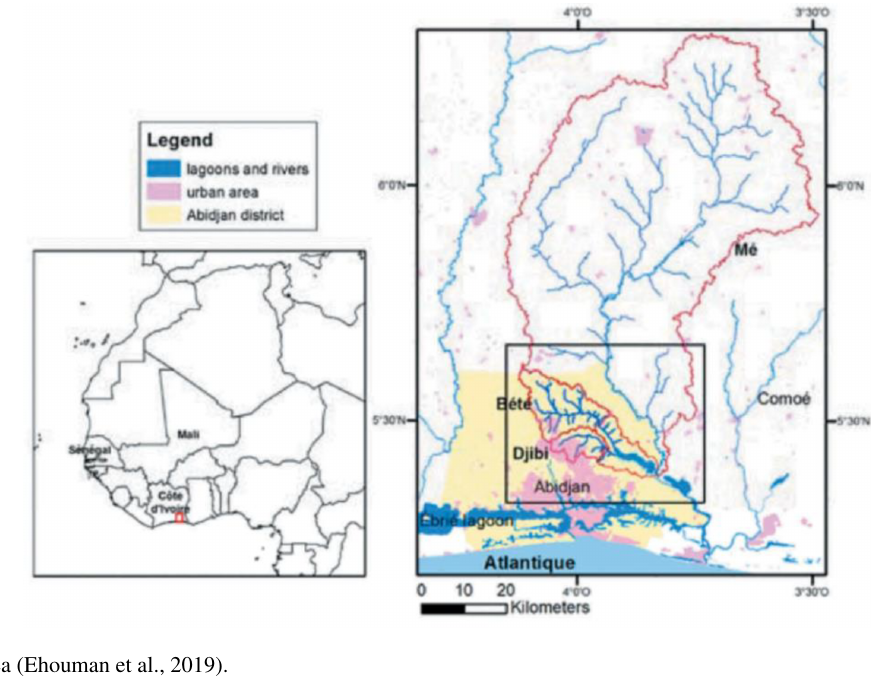
Figure 1. Study area (Ehouman et al., 2019).